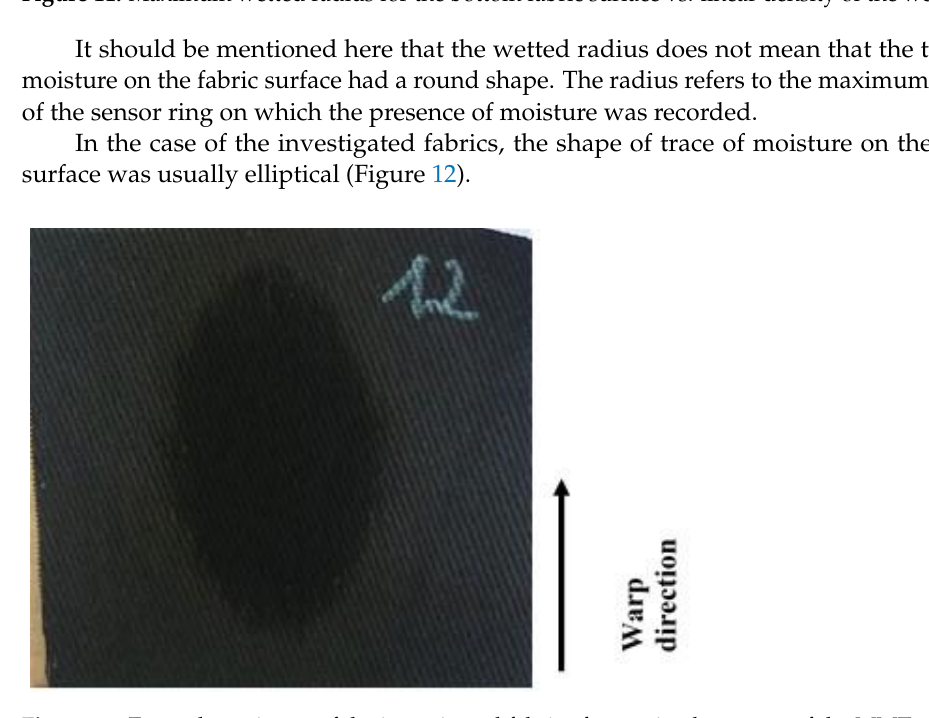
( b ) Figure 13. Comparison of liquid trace on variants with ( a ) 30 tex weft yarn and ( b ) 100 tex yarn. For each fabric variant, 10 repetitions of measurement were performed. After each test, a picture was taken. Due to this fact, we have 10 pictures of the liquid trace on the fabric surface for each fabric variant. The pictures were analyzed to determine the average diameters in both directions for each variant. In the presented pictures (Figure 13), the difference between diameters in the warp direction of both compared variants is ca. 1 cm.